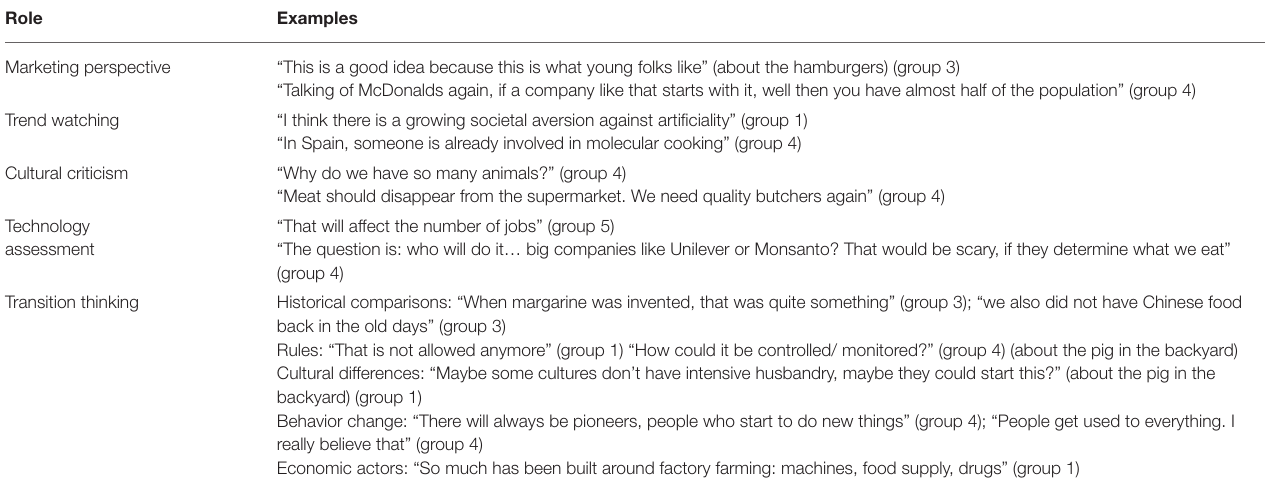
TABLE 2 | Role-taking statements—emerging mainly in groups 1, 3, and